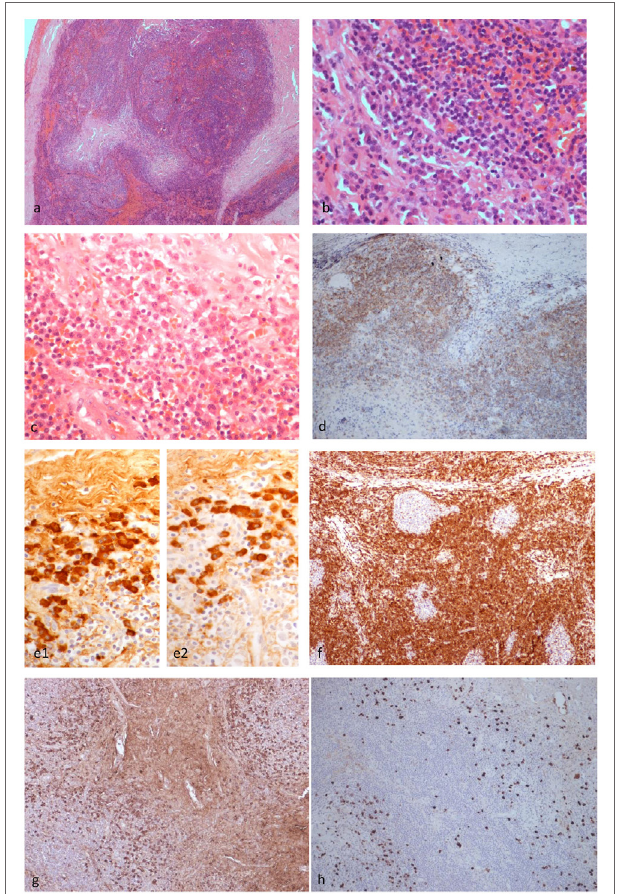
FIGURe 4 | Histopathological findings of patient 2. The right orbital mass consisted of cellular lymphoid nodules separated by hyalinized fibrous septa, but in areas, these nodules were coalescing (H&E × 4) (a) . The nodules showed reactive germinal centers (GC) surrounded by small-sized lymphocytes (H&E × 20) (B) . The lymphocytes did not show cytologic atypia (H&E × 40) (C) . CD20 monoclonal antibody staining revealed that the lymphoid nodules consisted of B cells, and the interfollicular B cells were within normal limits ( × 10) (D) . The plasma cells are polytypic for kappa (e1) and lambda (e2) light chain ( × 10) (e) . Staining with BCL6 and BCL2 antibodies revealed the presence of BCL6 (f1) and absence of BCL2 (f2) in the GC (F) . Staining with CD5 and cyclinD1 antibodies revealed that the B cells in the mantle zone were negative for both CD5 (g1) and cyclinD1 (g2) in the GC (G) . A small number of IgG4 positive plasma cells surround the hyperplastic lymphoid follicles ( × 10) (H) .